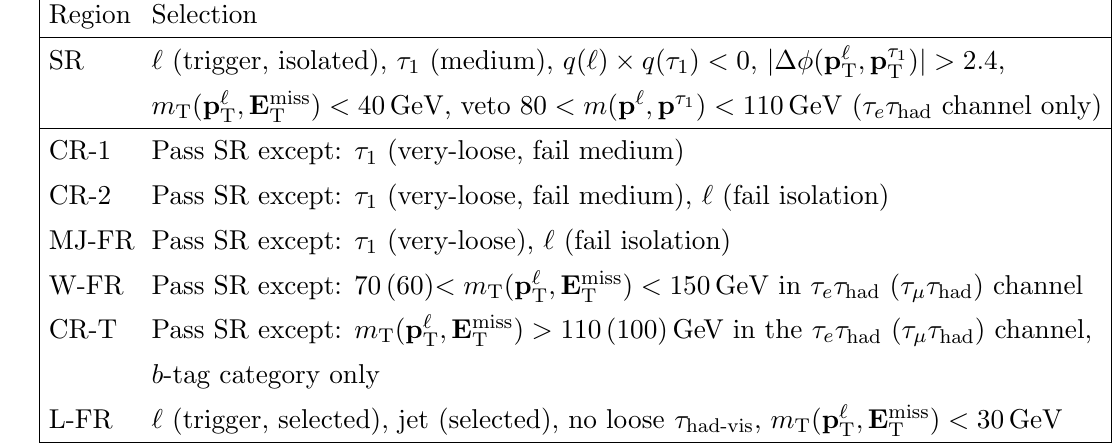
Table 2. De(cid:12)nition of signal, control and fakes regions used in the (cid:28) lep (cid:28) had channel. The symbol ‘ represents the selected electron or muon candidate and (cid:28) 1 represents the leading (cid:28) had-vis candidate.